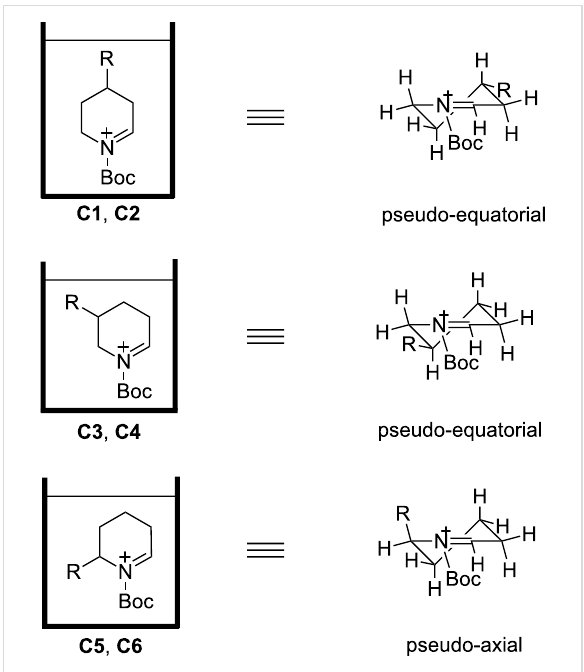
Figure 4: Summary of the conformations of N -acyliminium ions C1 – C6 .